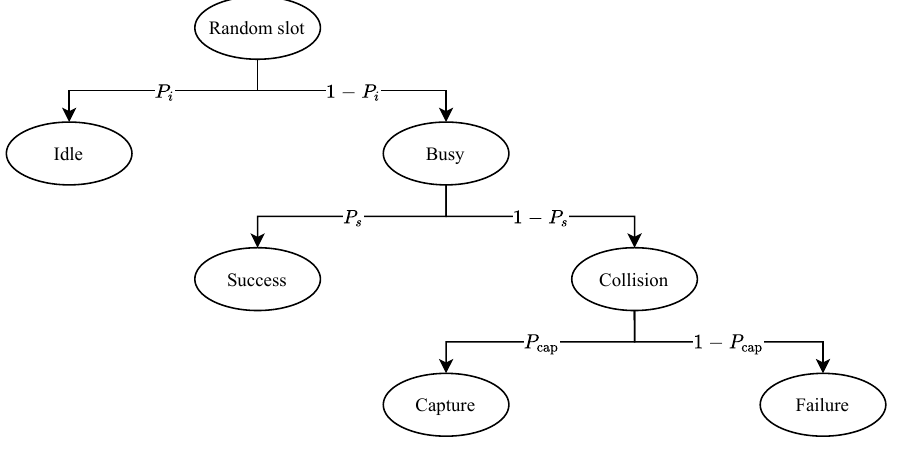
Figure 3. Different states of a randomly chosen